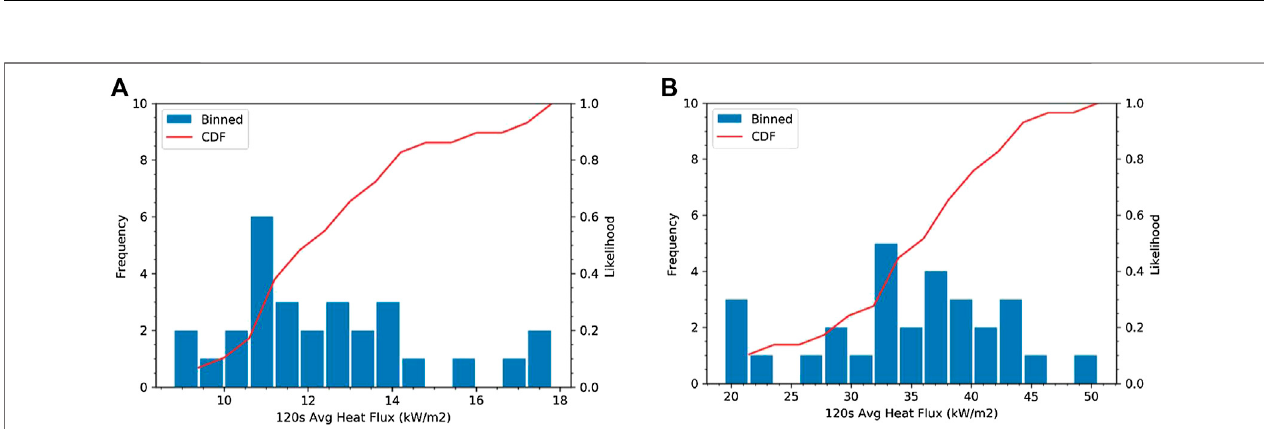
FIGURE5| Histogramof120saverageheat fl uxalongwithCDFfordatafromtest (A) FF6with0 m/swindand (B) FF14with2.0 m/sofwind.Testshadapilemass of 3.0 g containing fi rebrands with a diameter 4.75 mm, length 50 mm, and 0% MC.